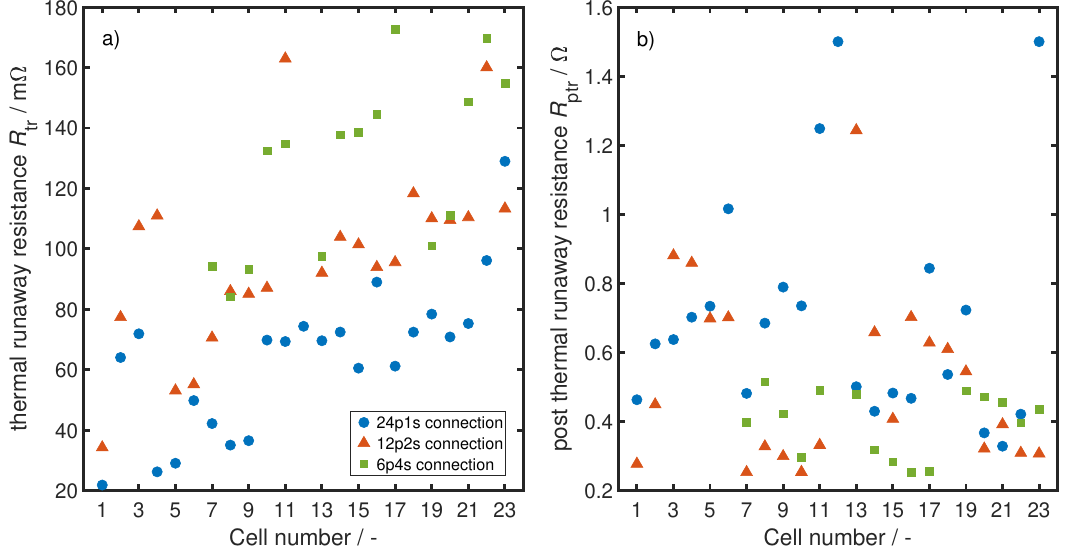
Figure 7. ( a ) parameter estimation results for the cell resistance during TR R tr of the three different experiments. The rising resistance with increasing cell number is believed to be a result of a decreasing pressure on the cells due to the mass loss from ejected particles and venting gas; ( b ) parameter estimation results for the cell resistance after TR R ptr